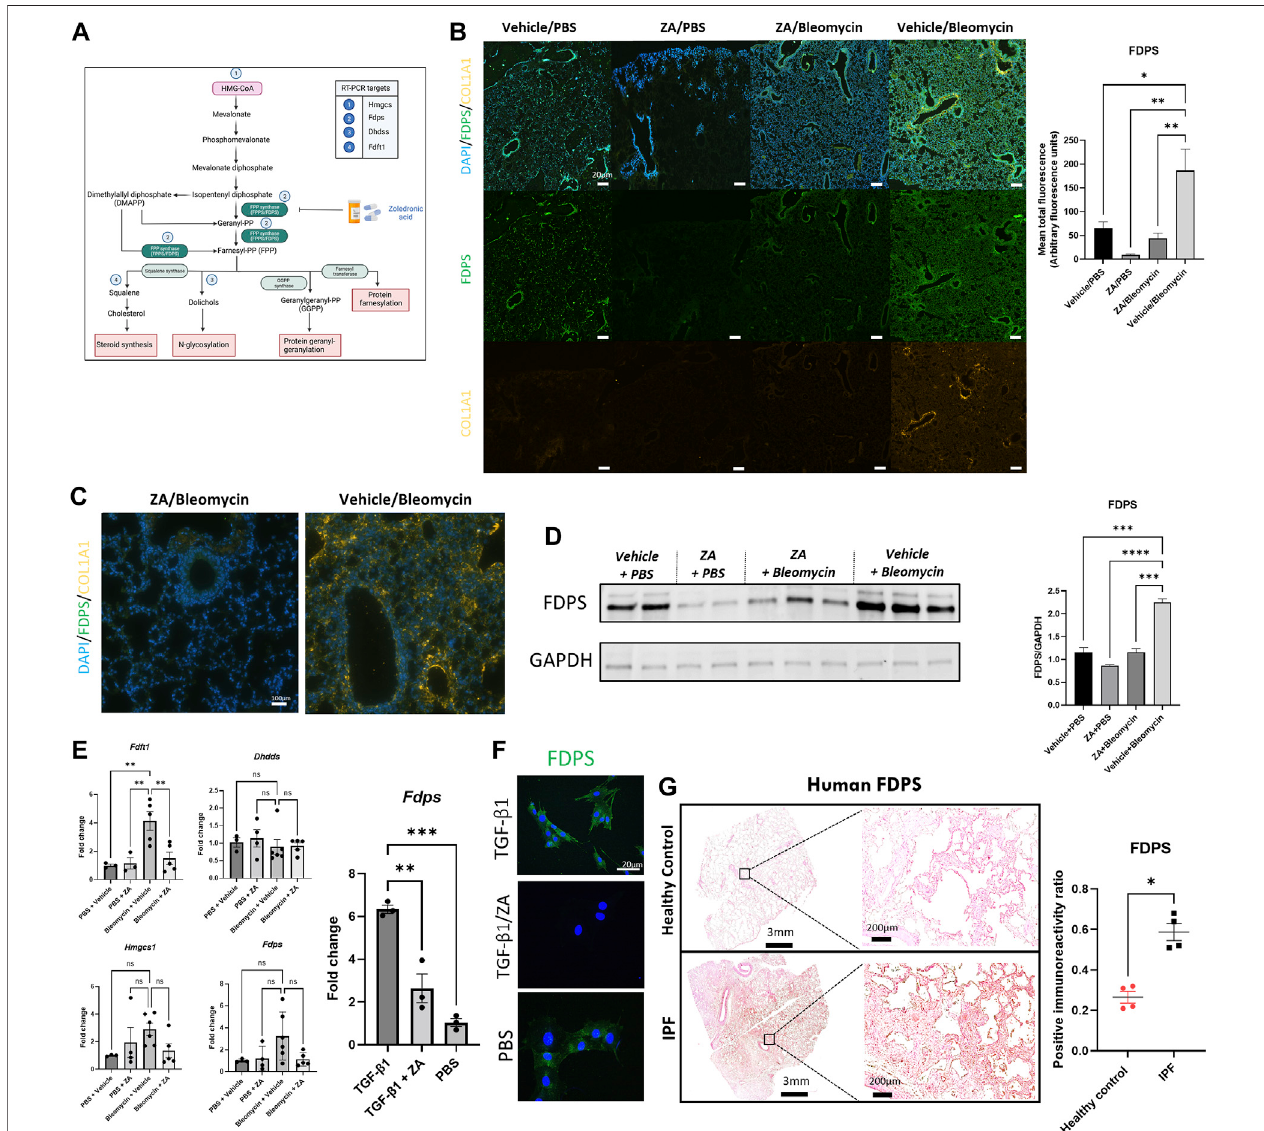
FIGURE 6 | Lower production of FDPS and COL1A1 in murine lungs upon ZA treatment. (A) Mevalonate pathway with key enzymes and intermediates highlighted inset and numbered points indicating PCR measurements (Hmgcs: hydroxymethylglutaryl-CoA synthase; Fdps: farnesyl diphosphate synthase; Dhdds: dehydrodolichol diphosphate synthase; Fdft1: farnesyl-diphosphate farnesyl transferase). (B) Murine lung immuno fl uorescence analysis showed decreased levels of immunoreactivity for FDPS and collagen 1A1 (COL1A1) in ZA (i.p.)-treated mice compared to bleomycin (Bleo) controls (scale bar = 20 μ m), with quanti fi cation of green fl uorescence.ZA-treatedandcontrolsampleswerecomparedtobleomycin-treatedsamplesusingaone-wayANOVAfollowedbyaDunnett ’ spost-hoctest(* p < 0.05; ** p < 0.01) and enlarged images of murine airways displaying co-staining of FDPS and COL1A1 (C) . (D) Mouse lung homogenate samples analyzed by SDS- PAGE,followedbyimmunoblottingusingrabbitantiseraspeci fi ctoFDPSrevealeddecreasedproteinlevelswithinZA-administered mice. (E) RT-PCRanalysisofmurine lung lysates reveals decreased levels of Fdft1 and Fdps in ZA-treated samples compared to bleomycin controls. Murine embryonic fi broblast cells stimulated with TGF- β 1and treatedwithZA/PBSfor48 hdisplayed signi fi cantlyreduced Fdps levelscompared toTGF- β 1controlascon fi rmedby (F) immuno fl uorescentstainingofTGF- β 1 treated MEF cells (scale bar = 20 μ m). (G) FDPS immunoreactivity was measured in human IPF and control resected lung tissues, with IPF tissues showing signi fi cantly more immunoreactivity than control tissue (* p = 0.0286) as compared using an unpaired t test with Welch ’ s correction. Scale bar = 3 mm and 200 μ m for inset